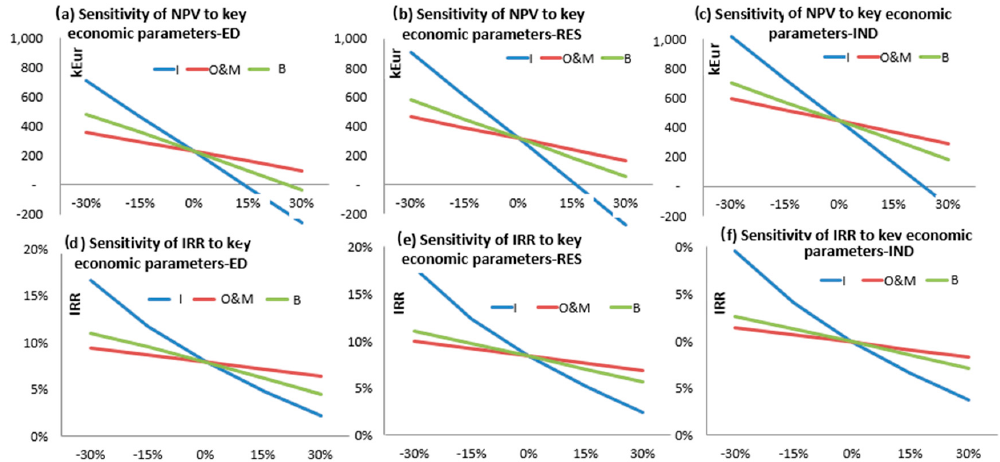
Figure 4. Results of the economic analysis and sensitivity of investment to to investment cost (I), operation and manteinance factor (O&M) and biomass supply cost (B). From top left to bottom right: sensitivity of NPV for the only electricity case ( a ), sensitivity of NPV for the residential heat demand case ( b ), sensitivity of NPV for the industrial heat demand case ( c ), sensitivity of IRR for the only electricity case ( d ), sensitivity of IRR for the residential heat demand case ( e ), sensitivity of IRR for the industrial heat demand ( f ).